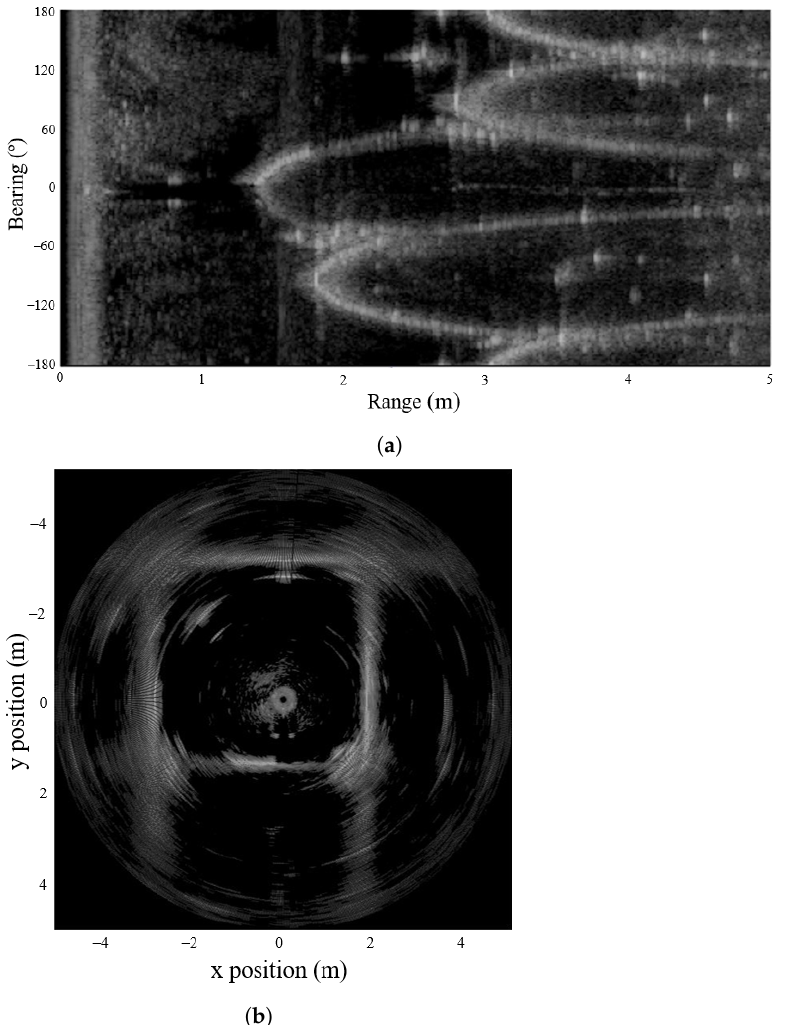
Figure 11. Results of different image composition techniques. ( a ) Image composed based on polar coordinate system and ( b ) image composed based on cartesian coordinate